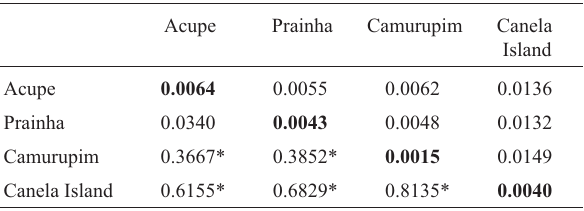
Table 3 - Fixation indices Fst (below diagonal), inter-population average distance matrix according to the Tamura-Nei model (above diagonal) and intra-population distance values (diagonal and